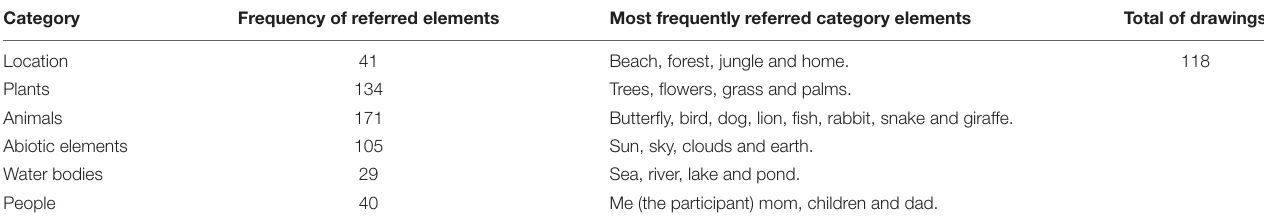
TABLE 2 | Number of drawings coded in each category.